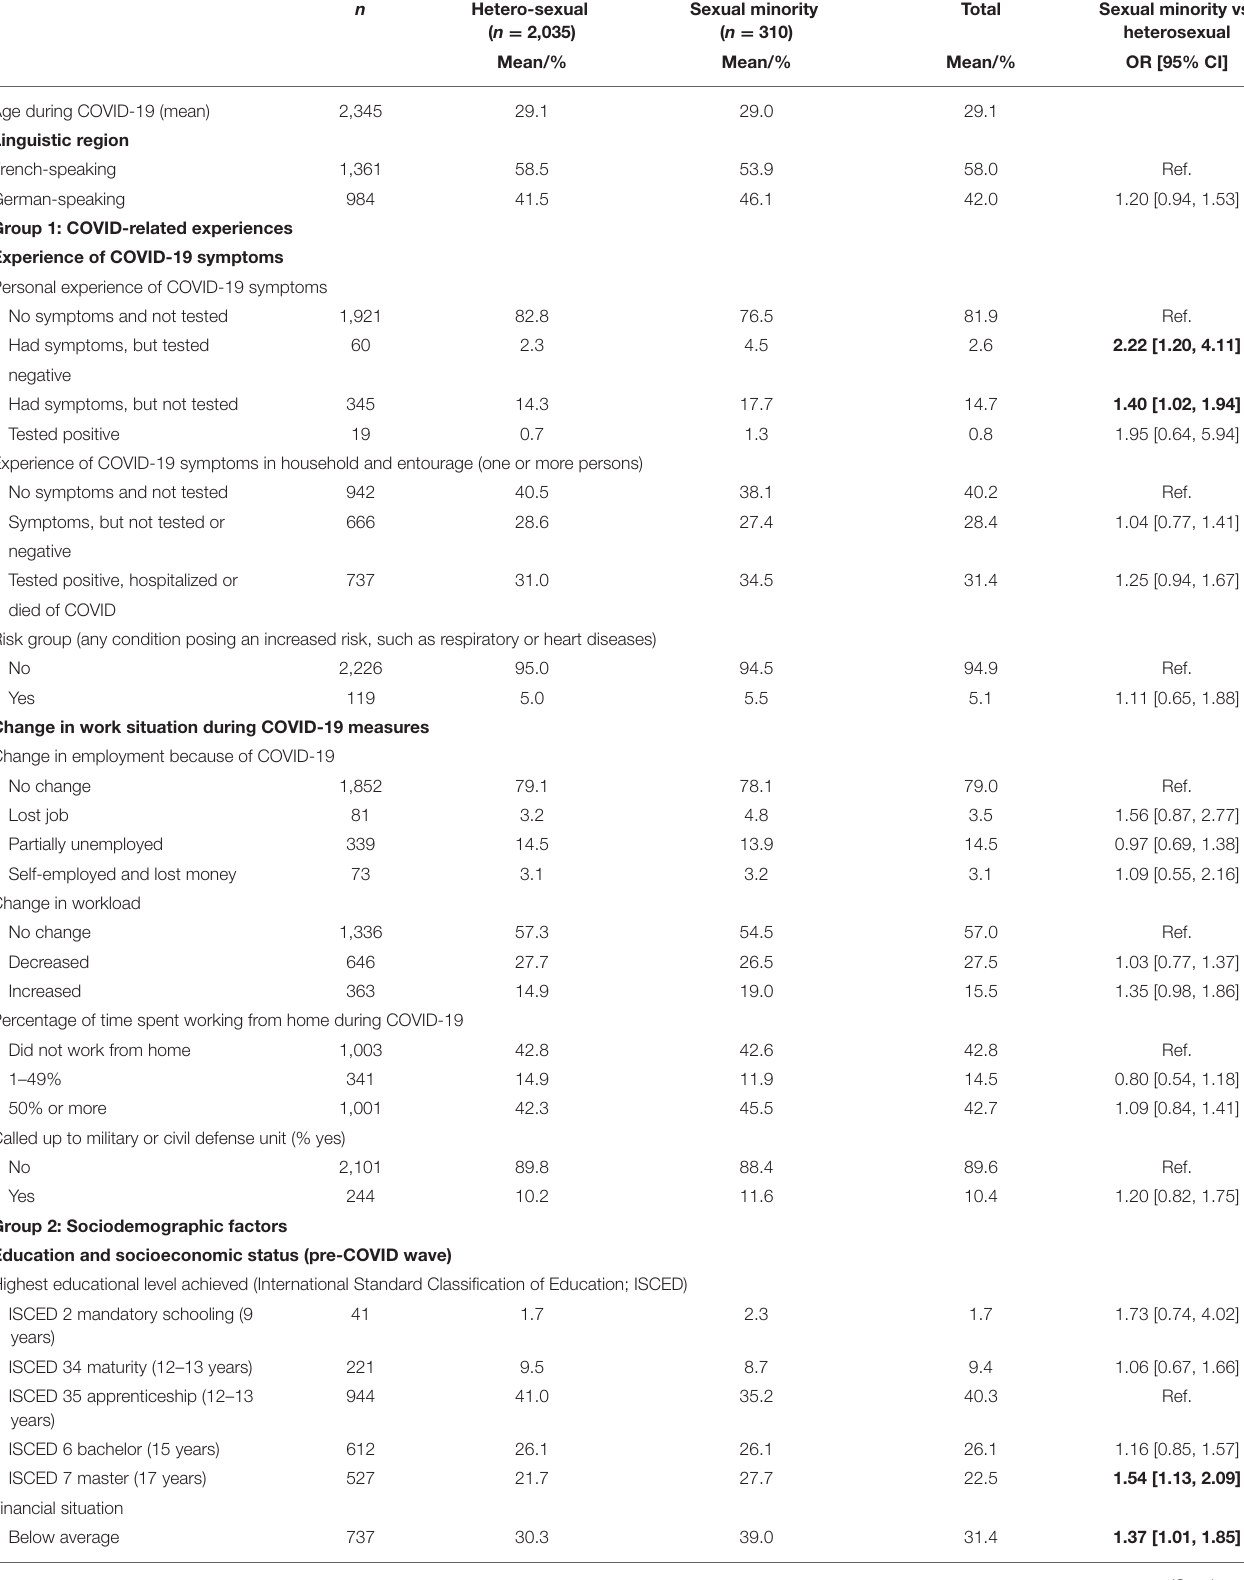
TABLE 1 | Descriptive statistics and results of multinomial regressions testing for differences between sexual minority men and heterosexual men (reference group). n Hetero-sexual Sexual minority Total Sexual minority vs. ( n = 2,035) ( n = 310) heterosexual Mean/% Mean/% Mean/% OR [95% CI] 2,345 29.1 29.0